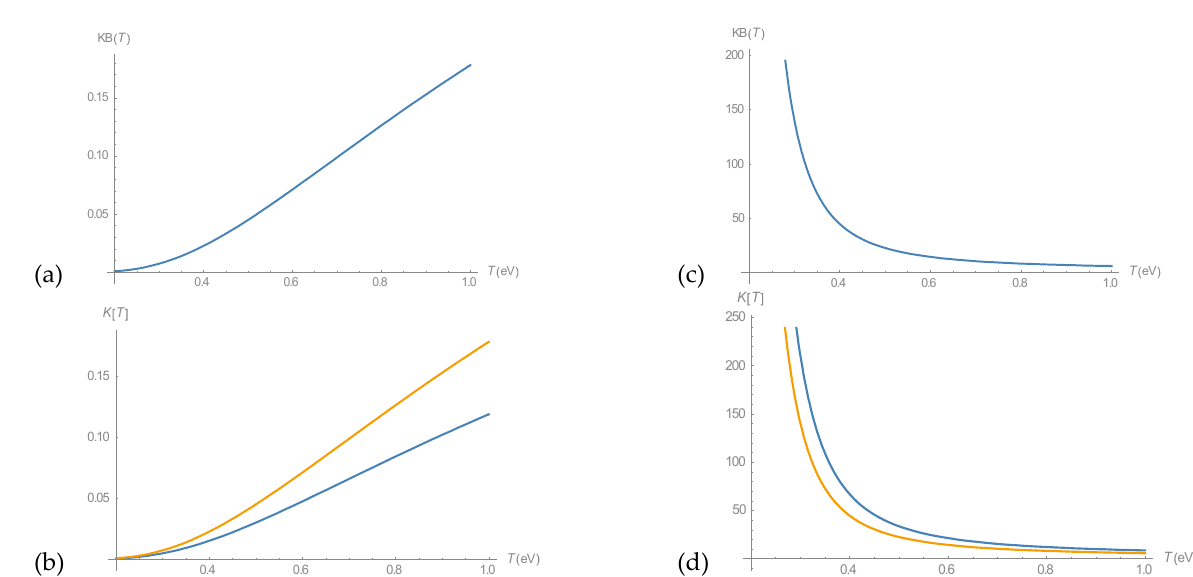
Figure 4. A dependence of equilibrium constant on mean-temperature T ( a ) K B (T) for the positronium in the magnetic field; ( b ) a comparison K o (T) for ortho -positronium (yellow) and K B (T) for the positronium in the magnetic field (blue); ( c ) a reverse constant 1/K B for the positronium in the magnetic field; ( d ) a reverse constant 1/K o for orto -positronium (yellow) and constant 1/K B for the positronium in the magnetic field (blue).